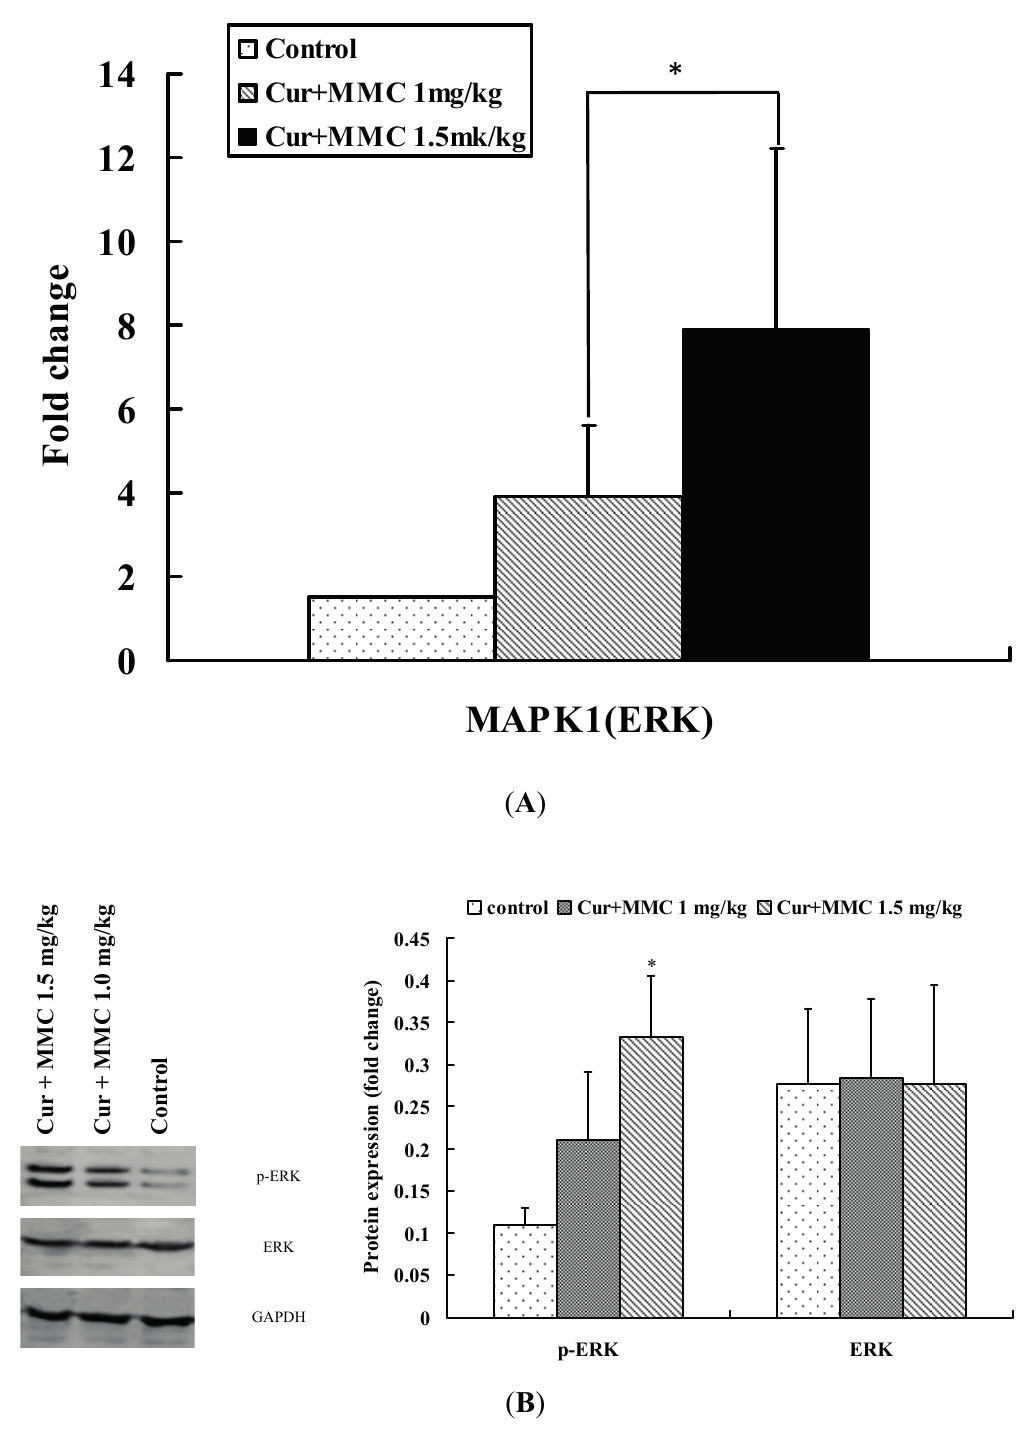
Figure 5. DE genes validated by quantitative RT-PCR (qRT-PCR) and Western blot analysis. ( A ) Total RNA was extracted from tumor tissues and qRT-PCR was performed as the description in Materials and Methods. Data represent as Mean ± SD from 4 determinations, and GAPDH was used to normalize the relative mRNA level. * p < 0.05; ( B ) Tumor lysates were analyzed for p-ERK and ERK with the corresponding antibodies. Values are mean ± SE from three independent experiments. * p < 0.05 curcumin plus MMC 1.5 mg/kg versus